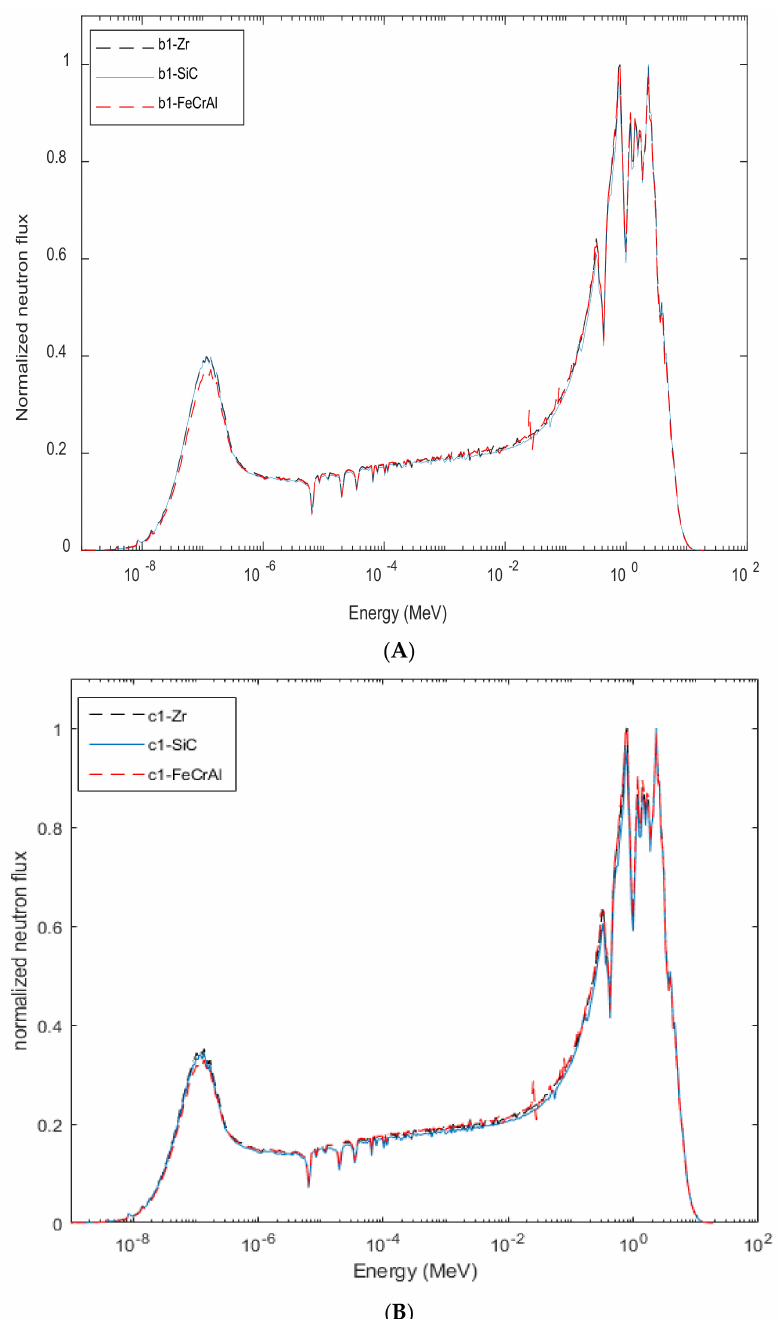
Figure 11. Normalized neutron flux distribution at BOC for different types of fuel assemblies ( A ) B1 − zircaloy, B1 − SiC, and B1 − FeCrAl, ( B ) C1 − zircaloy, C1 − SiC, and C1 −